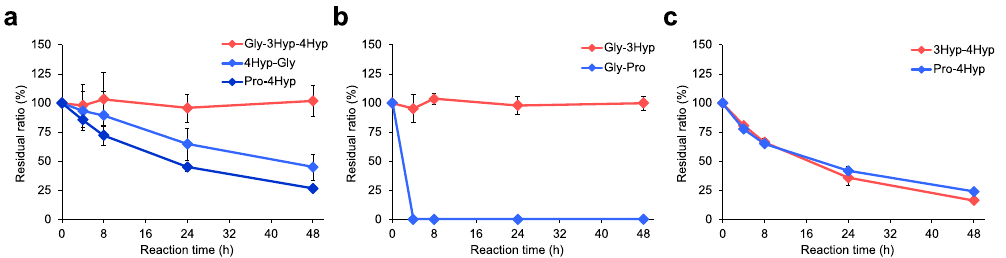
Fig. 4 Stability of 3Hyp-containing peptides in mouse plasma. Synthetic oligopeptide mixtures, including a Gly-3Hyp-4Hyp, 4Hyp-Gly, and Pro-4Hyp, b Gly-3Hyp and Gly-Pro, or c 3Hyp-4Hyp and Pro-4Hyp, were incubated with mouse plasma at 37 °C for 4, 8, 24, and 48 h. The residual ratio at each time point was calculated using the peak area ratio relative to the control (0 h) on LC − MS analysis in MRM mode. The data represent the mean ± SD ( n = 3).